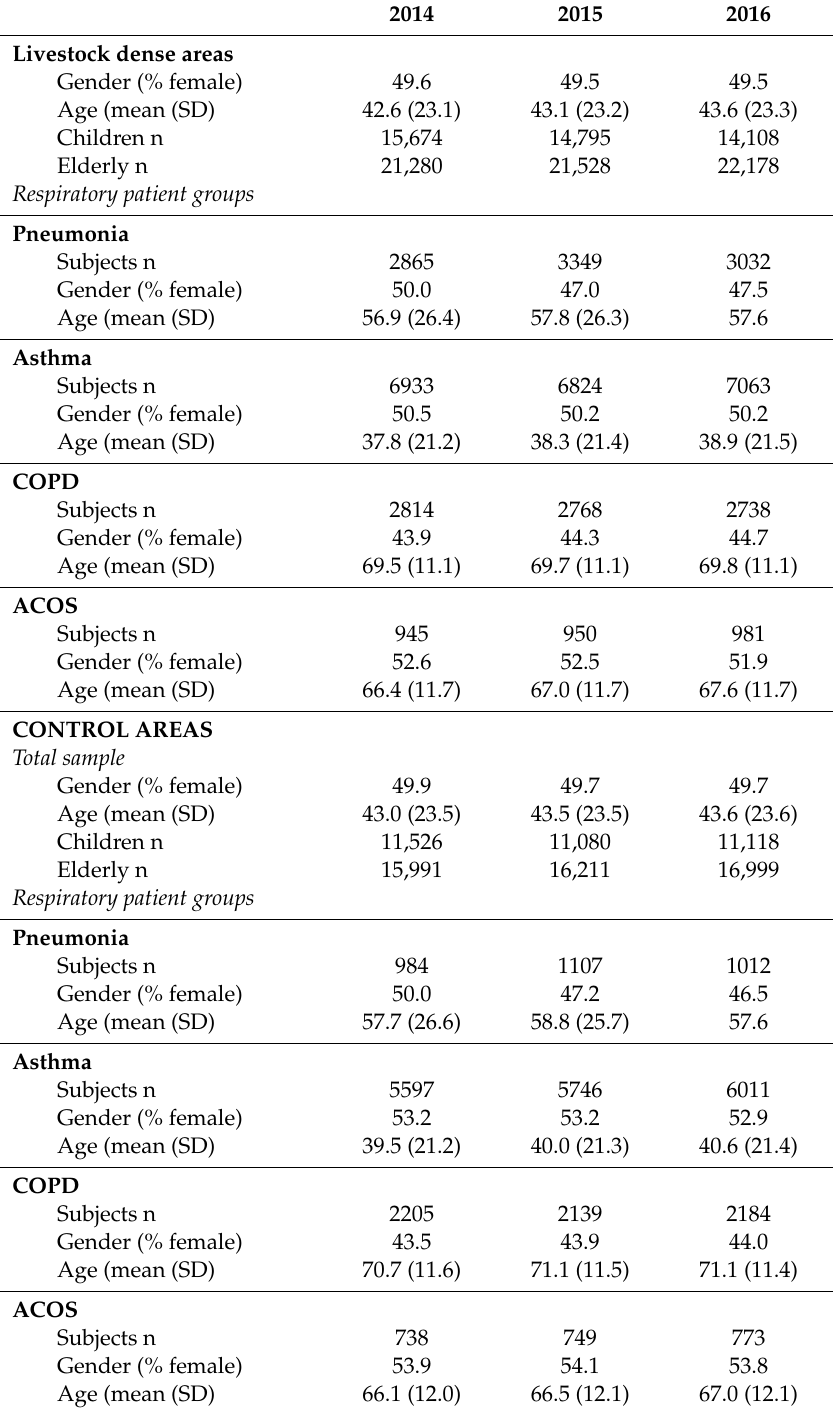
Table A4. Patient characteristics of the population in the study and control